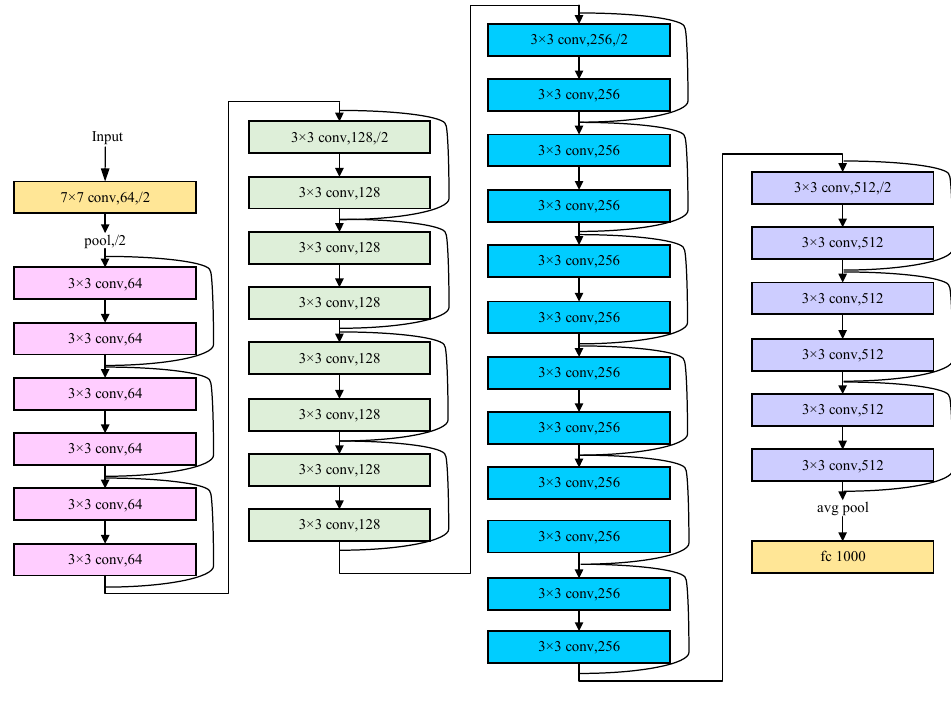
Figure 9. Basic structure of